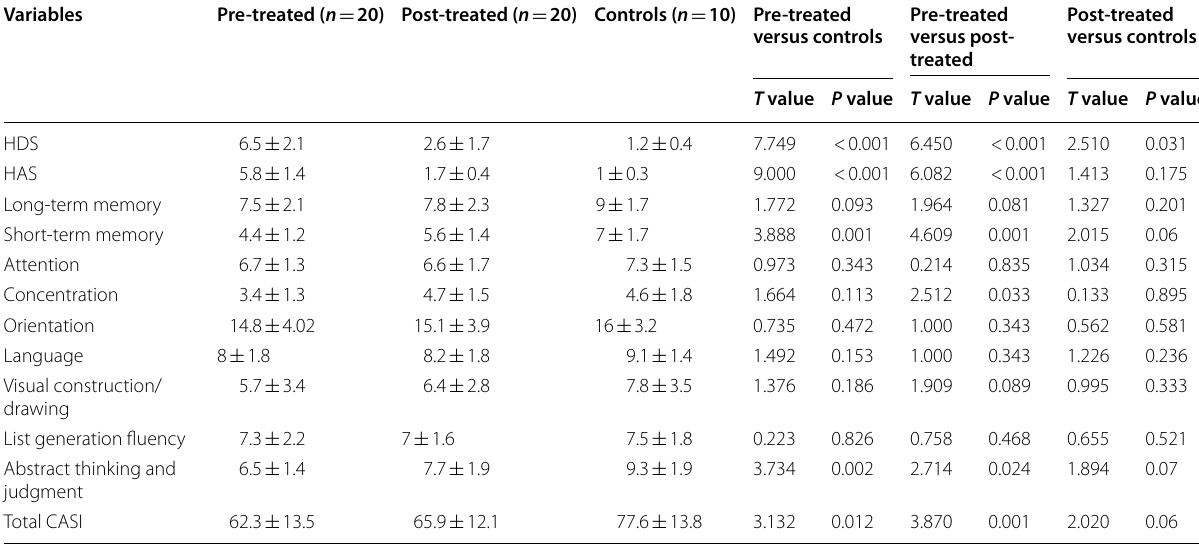
Values are presented as mean standard deviation or n (%). T -value for Student’s t -test. P -value < 0.05 is significant ± CASI: Cognitive Abilities Screening Instruments, HAS: Hamilton Anxiety Score, HDS: Hamilton Depression Score